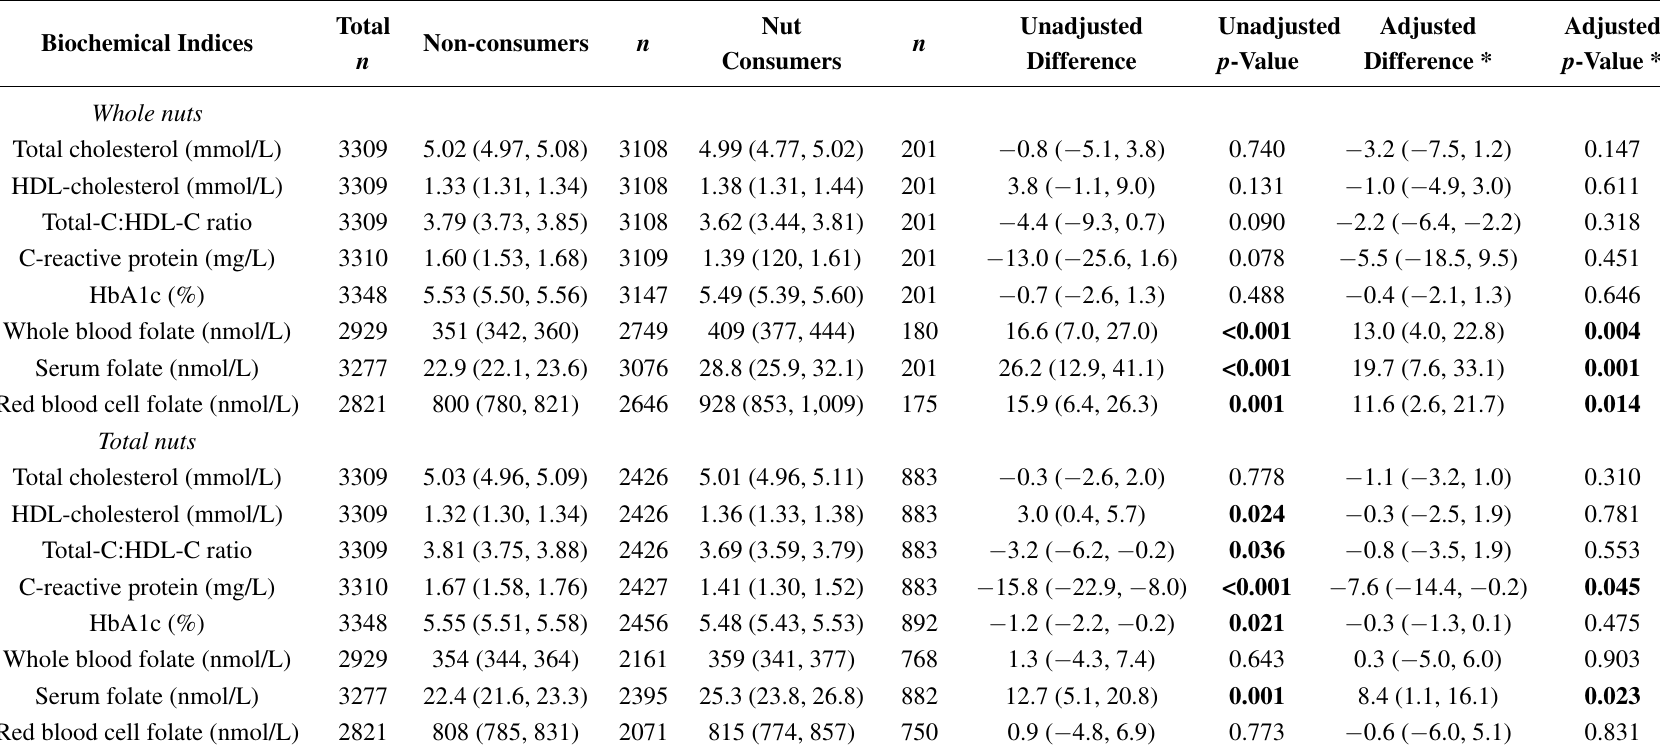
Table 3. Mean (95% CI) for biochemical indices for nut consumers and non-nut